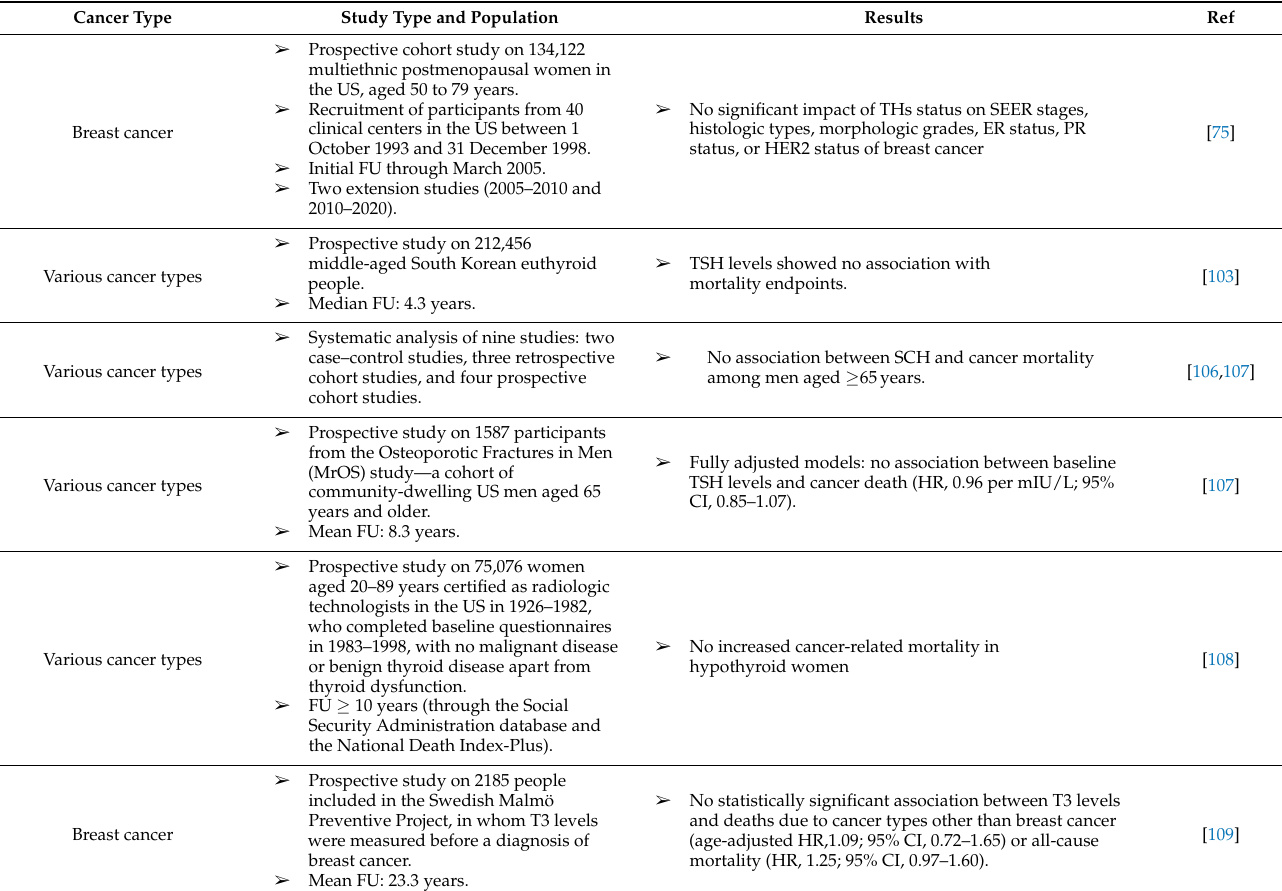
Table 4. Data indicative of no significant association between hypothyroidism or increasing TSH and cancer